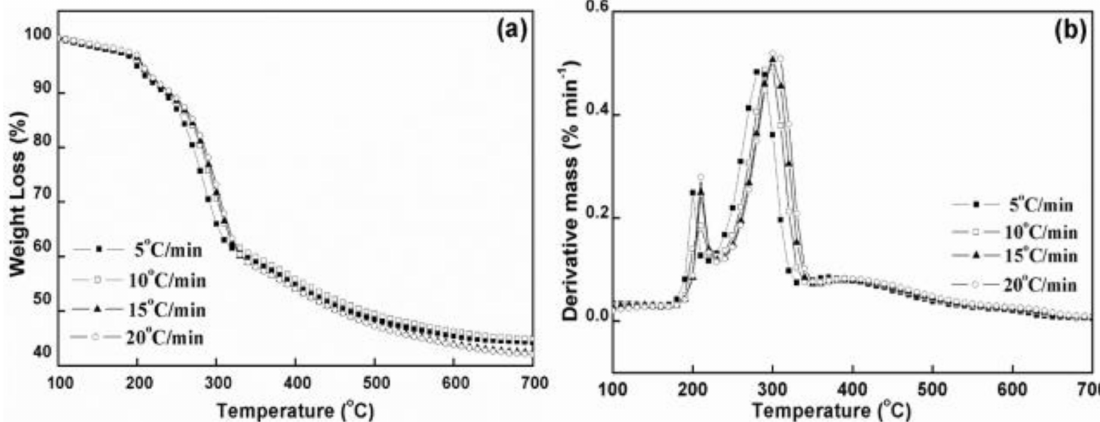
Figure 9. TG ( a ) and DTG ( b ) curves of CNF with 20 wt % clay under an air flow rate of 5, 10, 15 and 20 ◦ C / min.